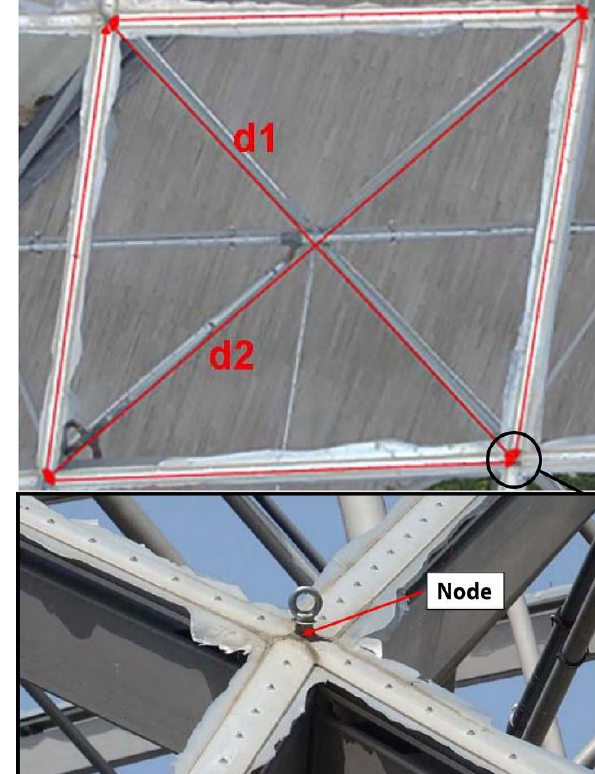
Figure 3: The 2012 space grid structure (a), the present one (b), a detail of the new cover (c), and an intrados view (d).